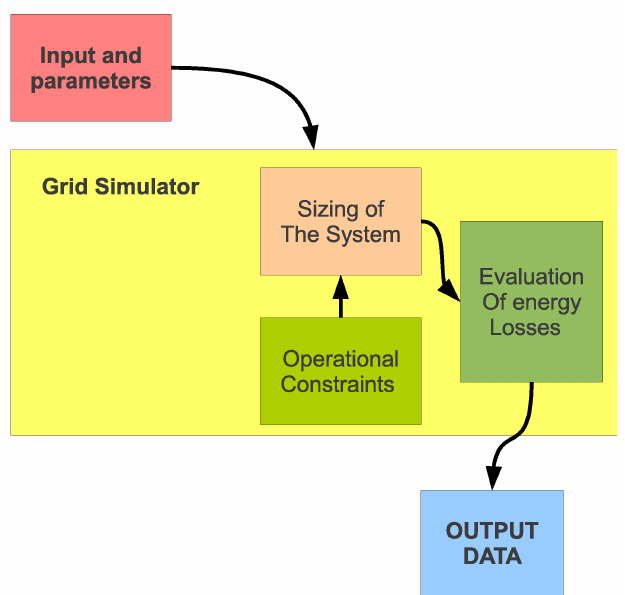
Figure 13. General layout of the grid